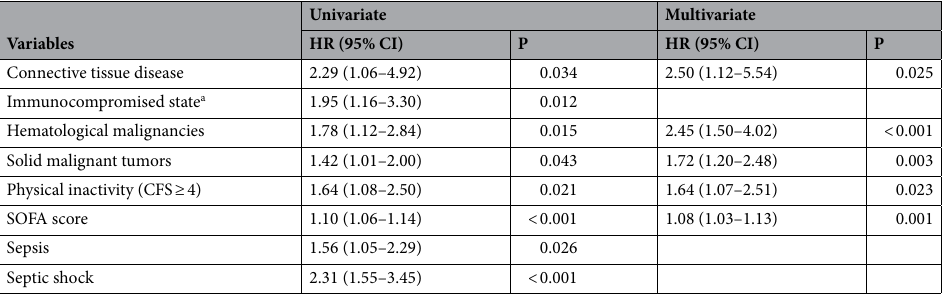
Table 3. Results of Cox regression analysis for hospital mortality. HR hazard ratio, CI confidence interval, CFS clinical frailty scale, SOFA sequential organ failure assessment. a HIV-infected patients with CD4 + counts of less than 200 cells/mm 3 , neutrophil counts of less than 1000 cells/mm 3 , or patients taking immunosuppressive drugs after organ